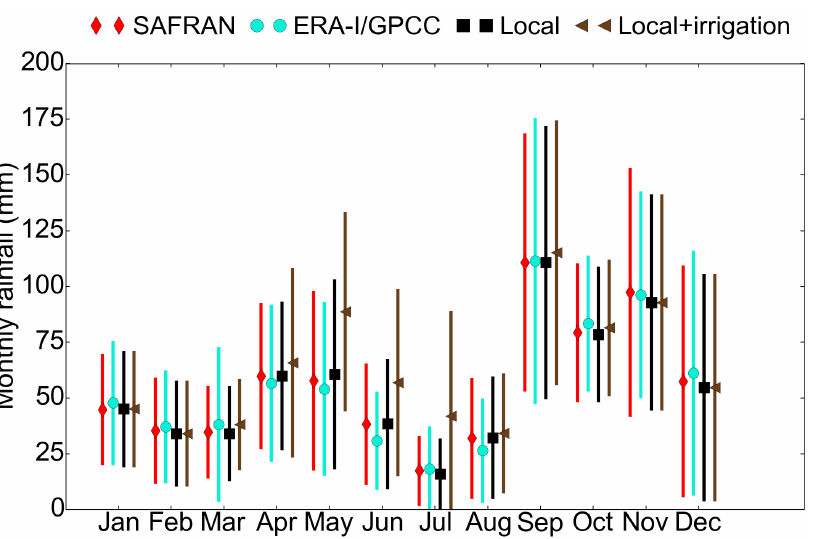
Figure 4. Comparison of SAFRAN, ERA-I/GPCC and local mean monthly rainfall. Irrigation amount added to the local rainfall is also presented. The vertical bars represent the inter-annual variability ( ± 1 standard deviation). Table 4. Evaluation of SAFRAN and ERA-I/GPCC cumulative rainfall against measurements over the 2001–2012 period at 3h, daily, 10- day, 30-day and yearly timescales. SDD and MD are given in absolute value in millimetres and in percentage of the mean local measurement in parentheses. 3h Daily 10-day 30-day Yearly Mean in situ meas. (mm)